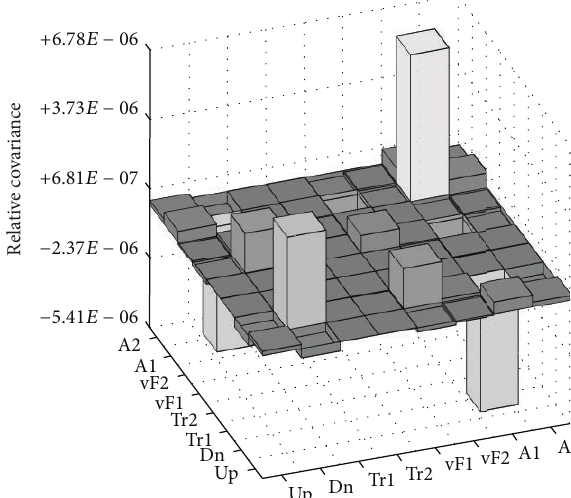
Figure 29: Homogenized property covariance due to infinite- dilution 𝜎 U 235 𝑓